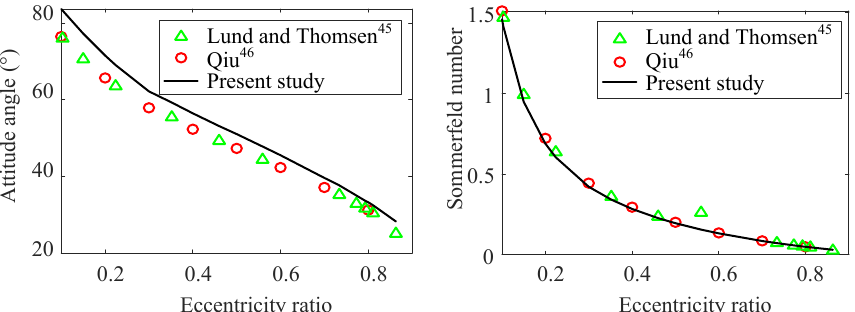
Figure 4. Attitude angle and Sommerfeld number compared with references